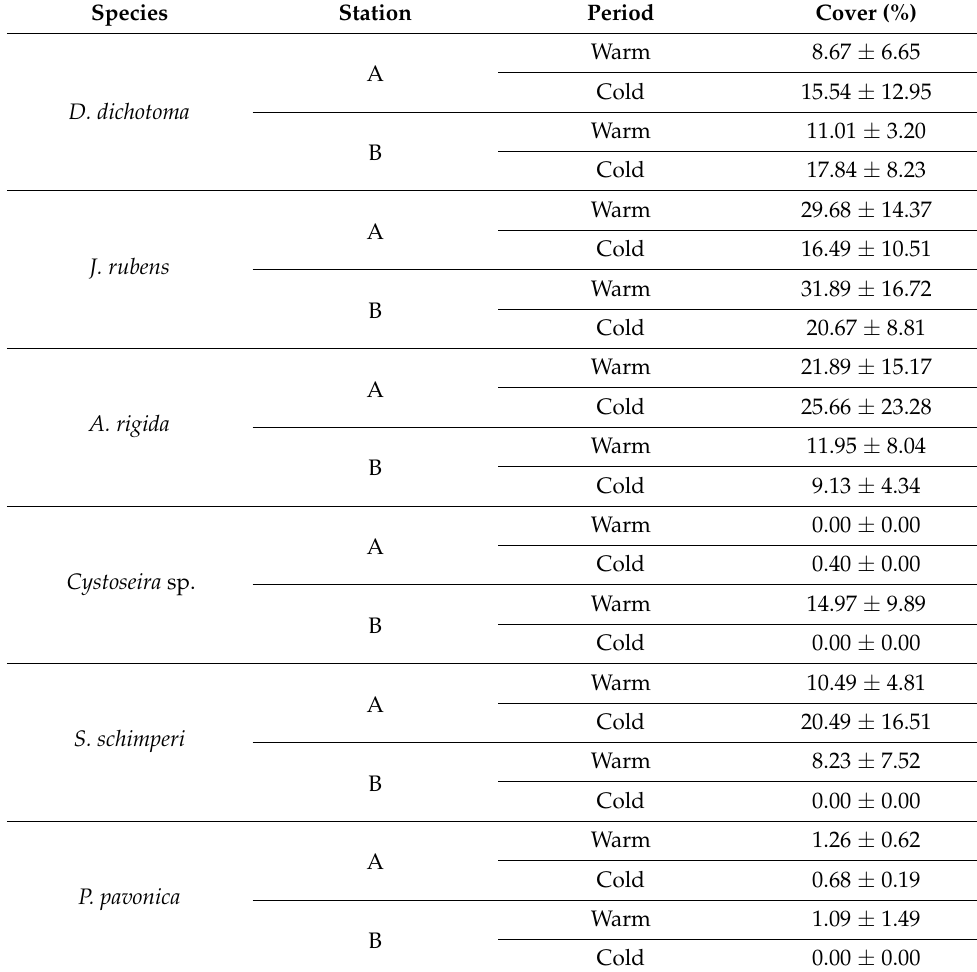
Table 1. Average values of quadrat cover percentage per macroalgae species found in the two stations over the cold and warm periods. Values are X ± SE ( n =